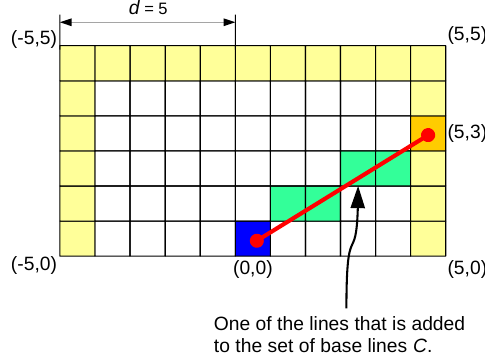
Figure 4. Calculation of the base lines. The Bresenham algorithm is applied to every pair of points defined by the central point (blue) and all the points in the grid’s perimeter (yellow).